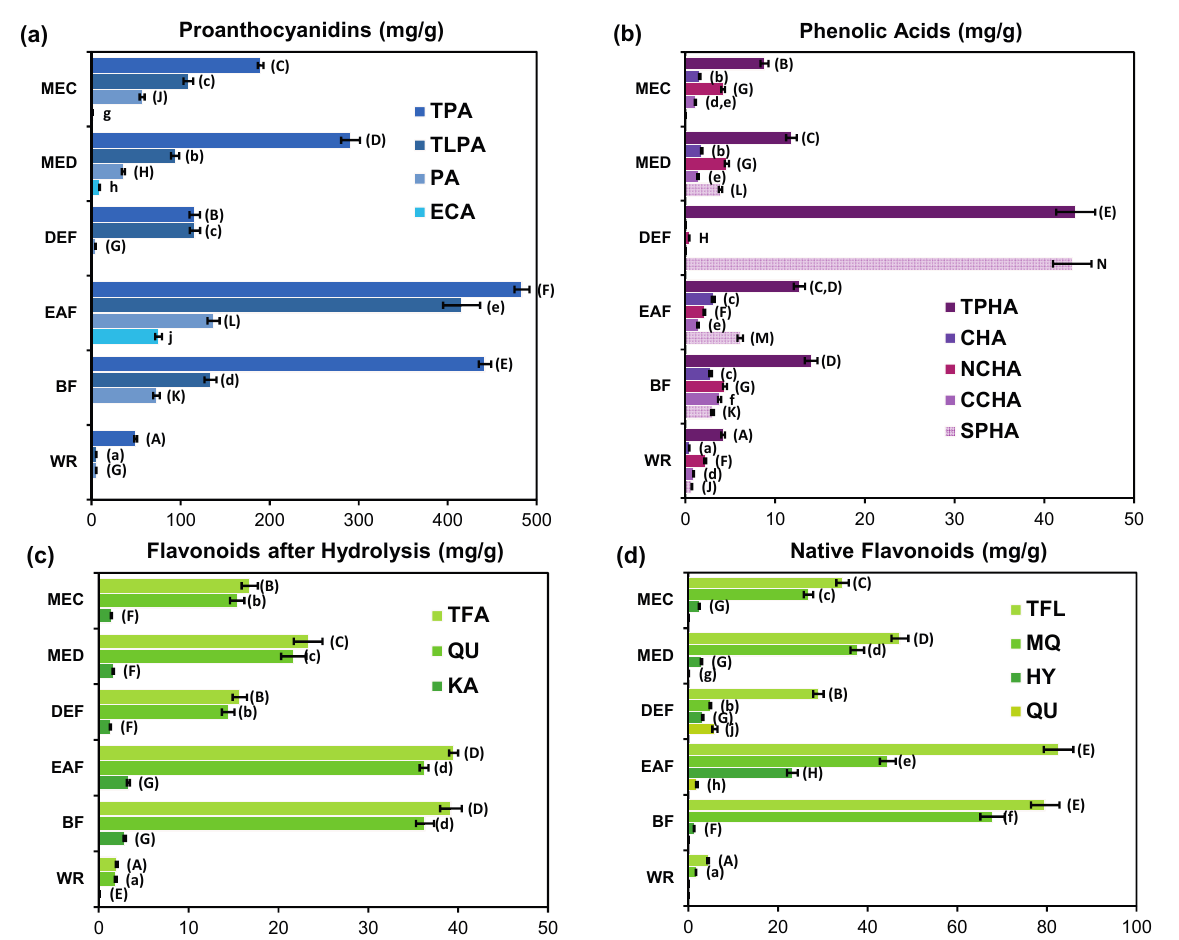
Figure 5. Quantitative data of G. procumbens dry leaf extracts: ( a ) proanthocyanidins; ( b ) phenolic acids; ( c ) flavonoid aglycones after acid hydrolysis; and ( d ) native flavonoids.